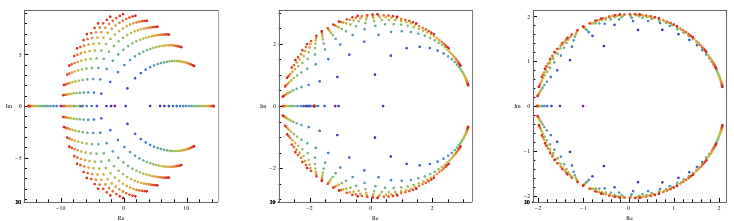
Figure 8. Stacking structure of S B n , q ( x ,5 ) for 2 ≤ n ≤ 30, q =